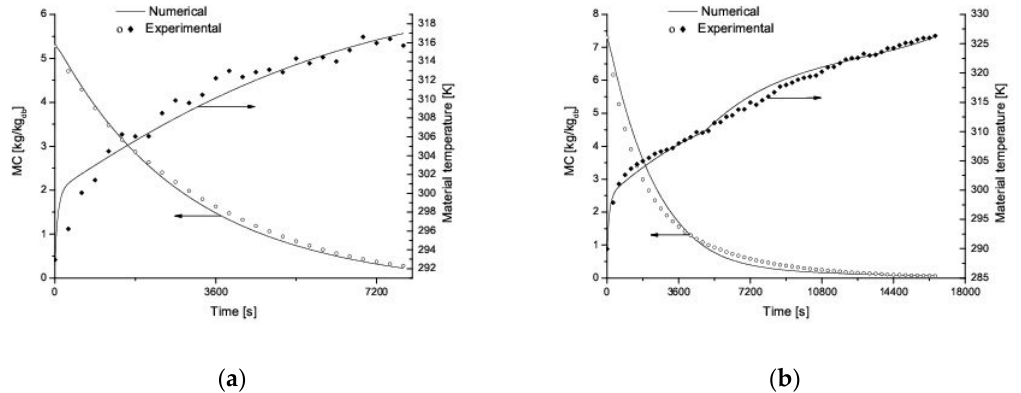
Figure 5. Drying kinetics of ultrasound-assisted convective drying: ( a ) Drying of apple—drying scheme CVUD_404200, and ( b ) drying of carrot—drying scheme CVUD_502200.